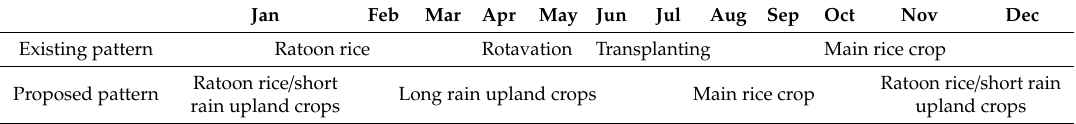
Table 2. Comparison of existing and proposed cropping